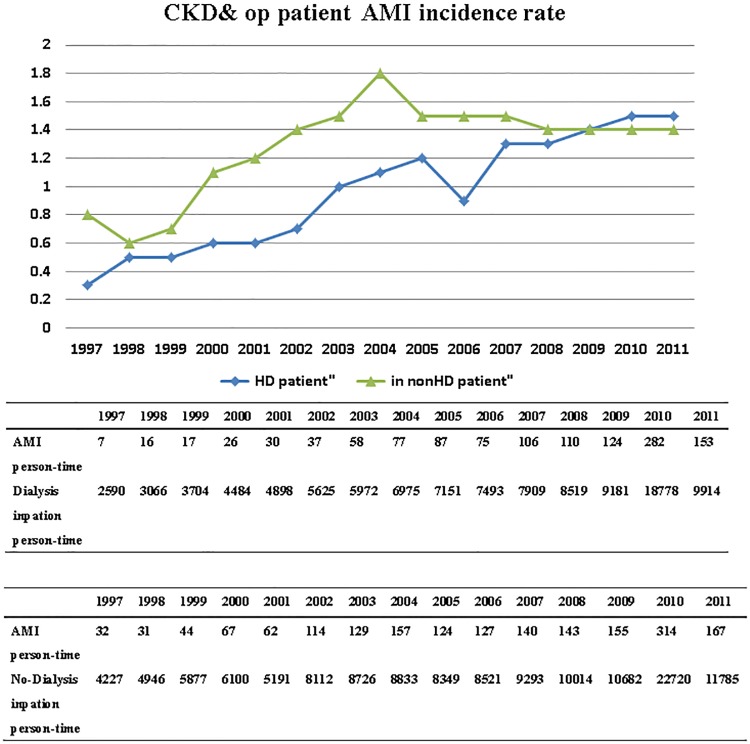
The rate of AMI in CKD (with/ without dialysis) cases with surgery in 15 years.AMI (Acute myocardial infarction); CKD (chronic kidney disease); op (operation).